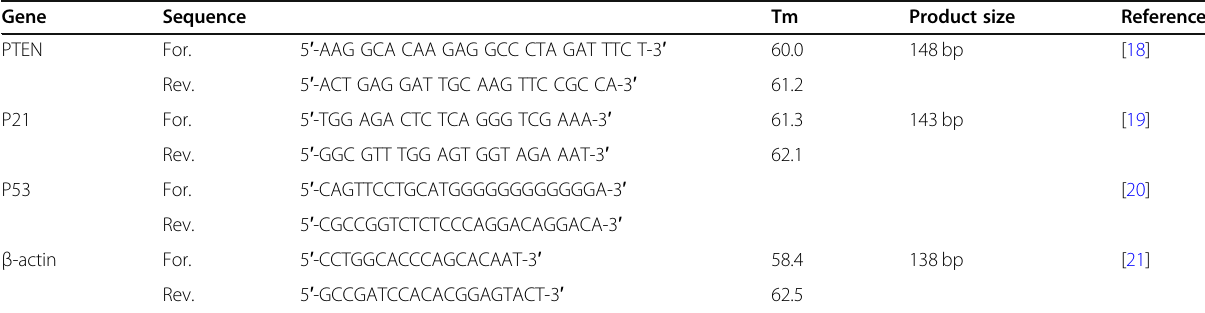
Table 3 QPCR primers